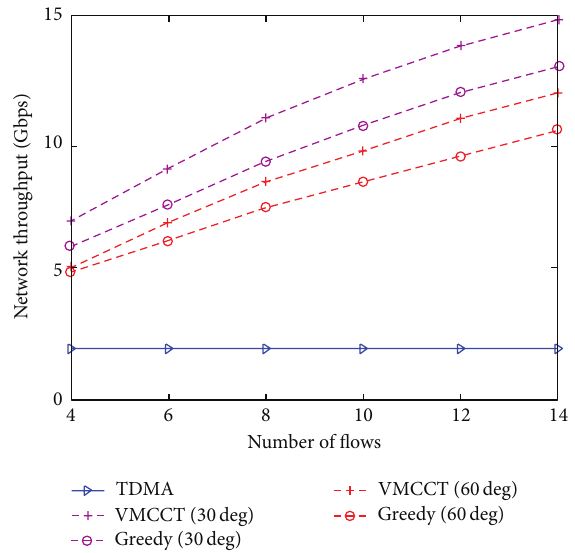
Figure 10: Improved network throughput versus flow density.